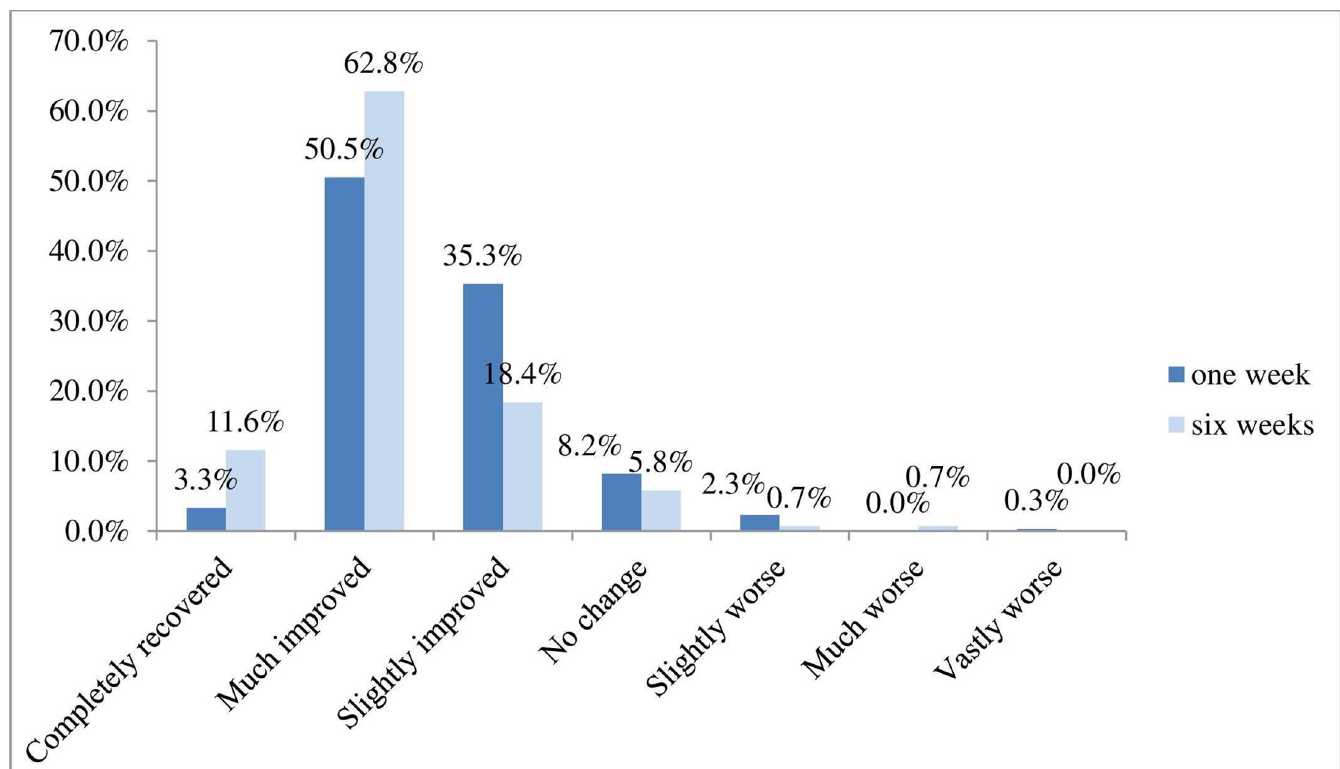
Fig 6. Global rating of change at one week and six weeks post treatment.